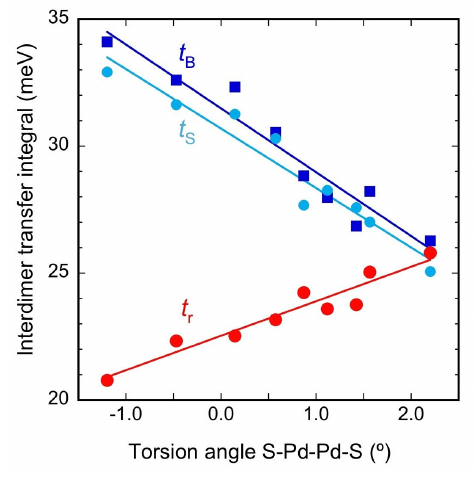
Figure 13. Interdimer transfer integrals as a function of the torsion angle of S–Pd–Pd–S ( Ф